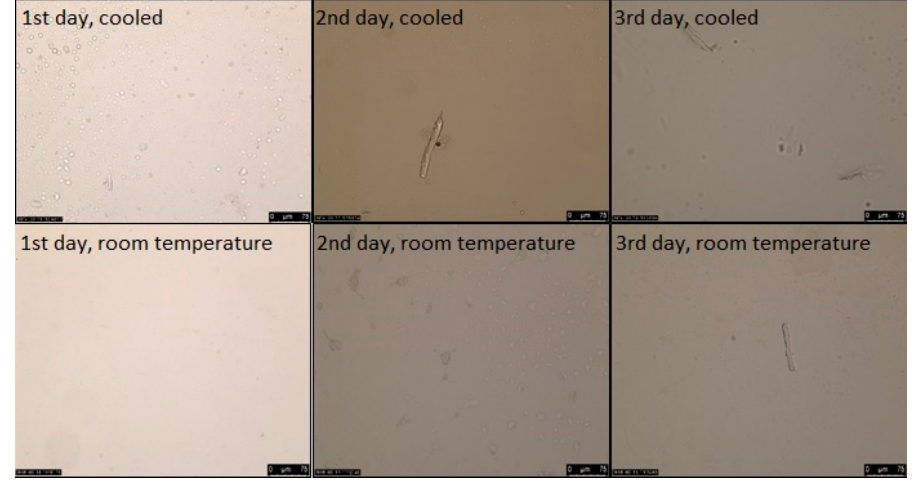
Figure 1. The NLC dispersions’ stability over the course of three days at different storage conditions. (The magnification was 200×).